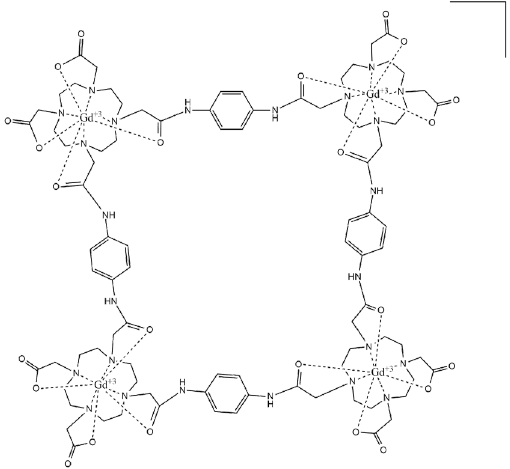
Figure 3. Closed tetrameric lanthanide complex.